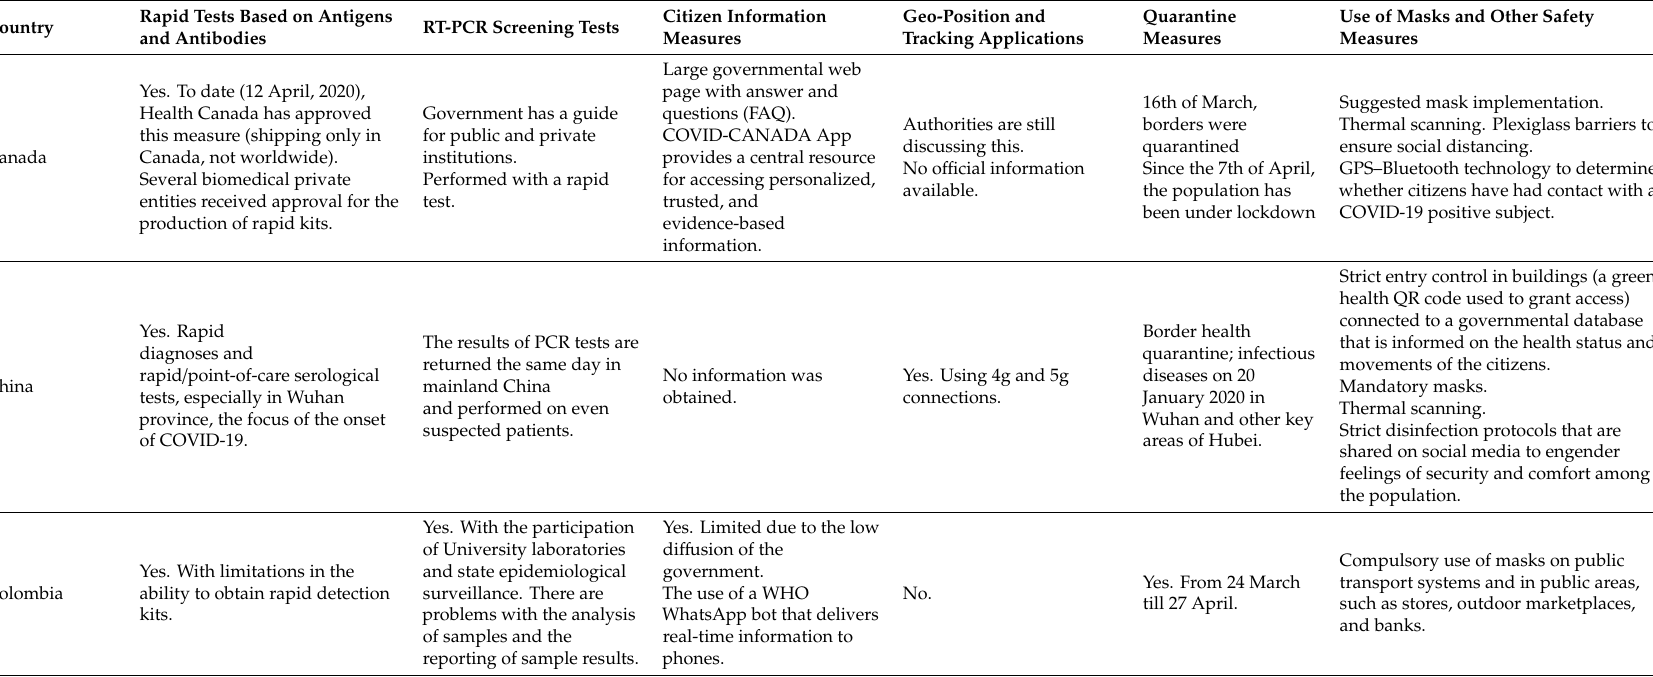
Table 1. Summary of epidemiological surveillance measures, use of molecular biology and rapid tests based on antigens and antibodies for coronavirus disease 2019 (COVID-19) detection, social isolation, and the application of technology to keep the population informed and controlled, as adopted by di ff erent countries.